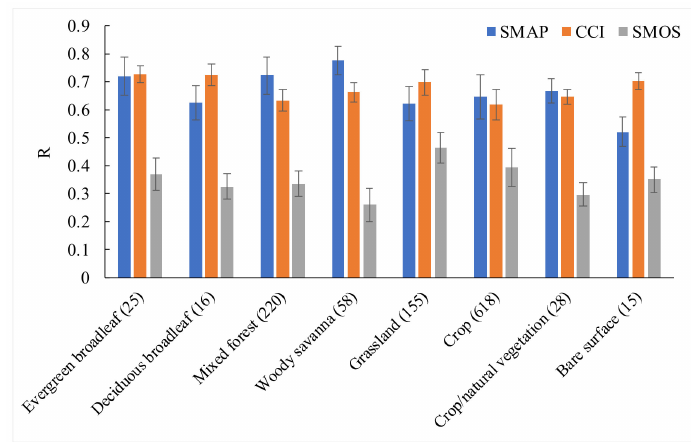
Figure 5. Average performance of R for SMAP, CCI, SMOS soil moisture products over di ff erent landcover types from MODIS. The numbers in parentheses represent the number of sites in the corresponding landcover types. Error bars show 95% confidence intervals obtained from standard